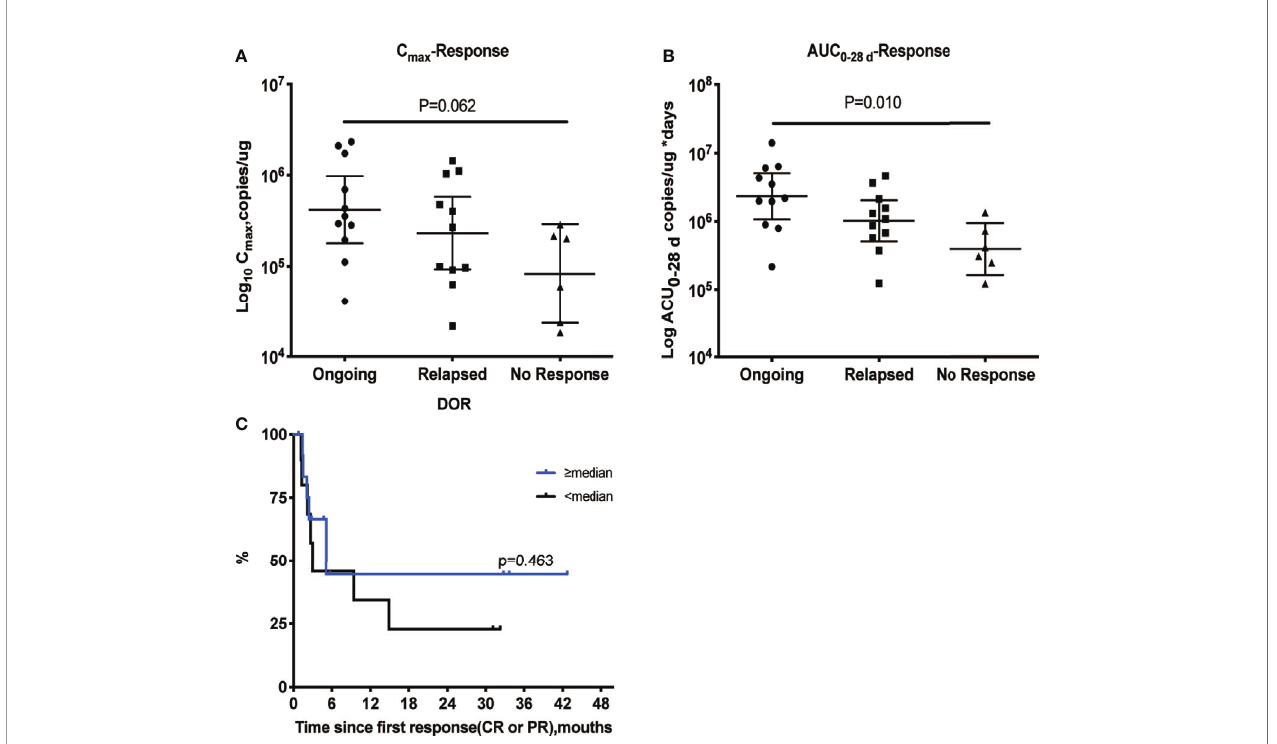
FIGURE 3 | Relationship between cellular kinetics and response. Relationship between C max (A) and AUC 0 – 28 d (B) . DOR in patients with a response (C) . Patients with an ongoing response at the last follow-up day had higher C max (A) and AUC 0 – 28 d values (B) . Patients with a higher-than-median C max had a potentially longer DOR than those with lower-than-median C max , but the differences were not statistically signi fi cant (P = 0.463) (C)